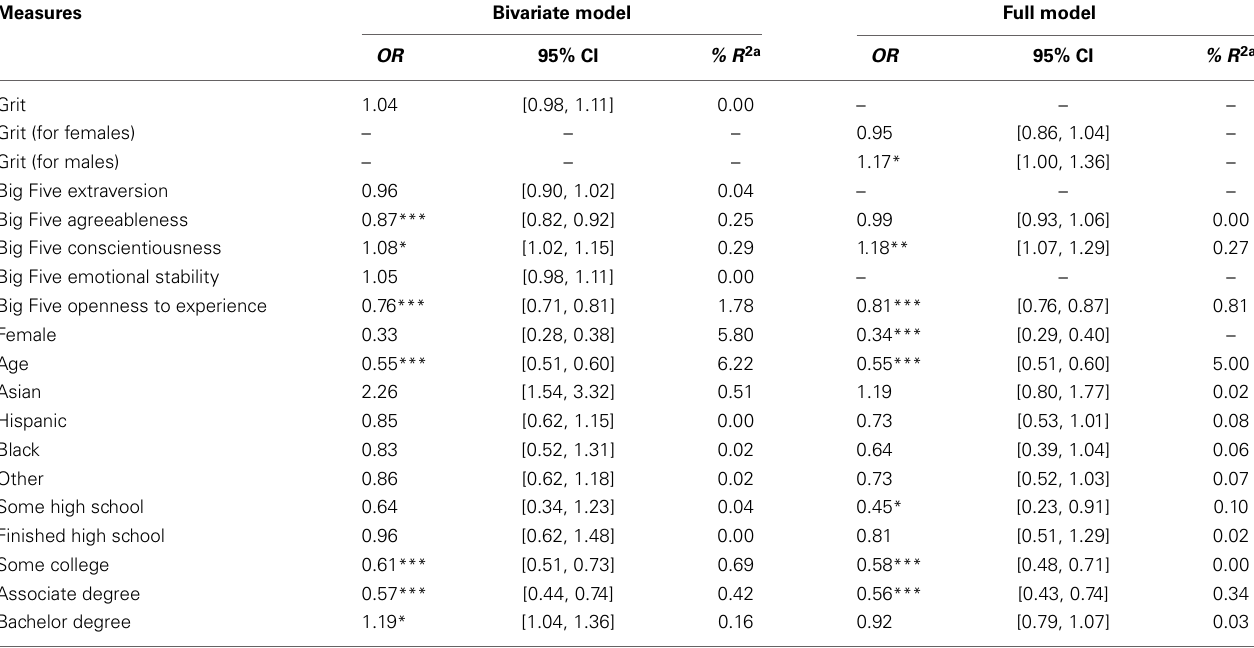
Table 4B | Bivariate and full logistic regressions predicting tendency to remain married (Study